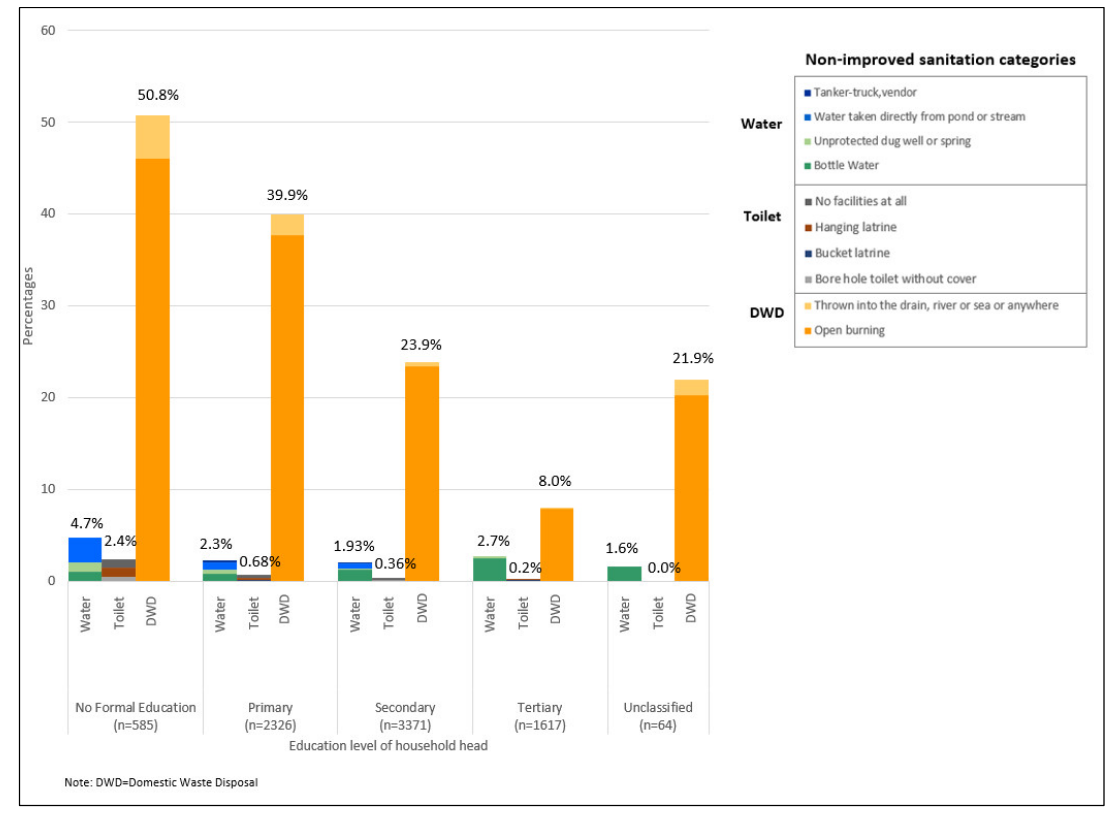
Figure 5. Non-improved sanitation categories by education.